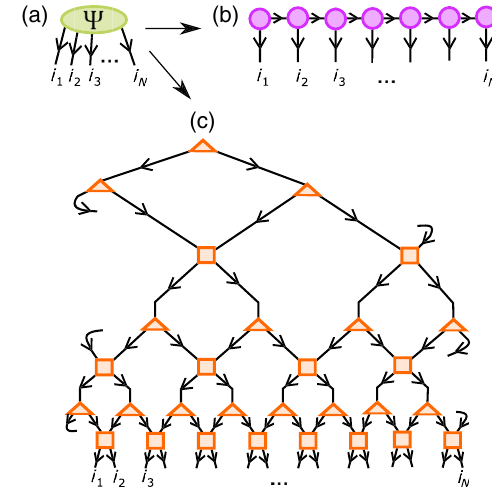
FIG. 2. Examples of popular tensor network decompositions of quantum-many-body states. (a) An N -index tensor Ψ that, e.g., stores the probability amplitudes of a quantum-many-body state in Eq. (6). (b) A MPS decomposition of tensor Ψ . It corresponds to a tensor network composed from tensors with at most three indices. Tensor Ψ is recovered by contracting together the tensor network. (c) A different and more elaborate tensor network decomposition of Ψ , called the MERA, which is composed of three-index tensors (triangles) and four-index tensors (squares). (Once again, tensor Ψ is recovered by contracting together the tensor